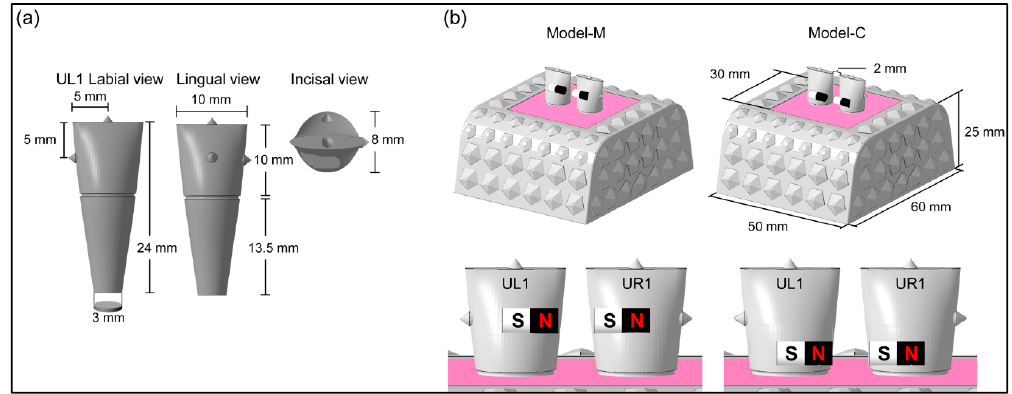
Figure 1. Typodont model used in this study. ( a ) Design and sizes of maxillary left central incisor (UL1), ( b ) scheme of typodont model.